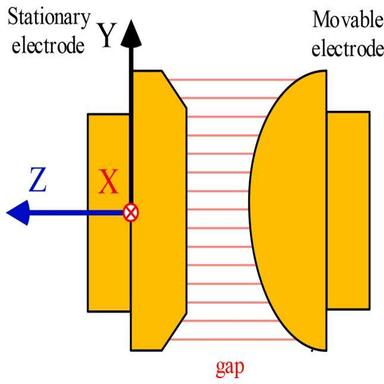
Schematic plot of separated electrode pair.